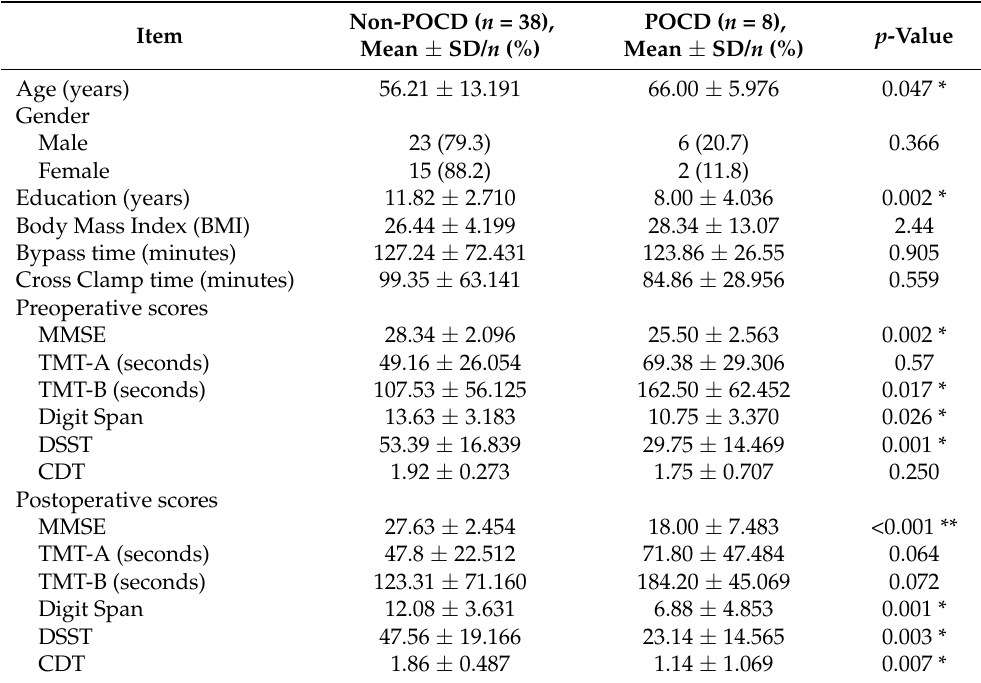
Table 1. Demographic, intraoperative characteristics, and cognitive assessment scores of patients in the POCD and non-POCD groups.